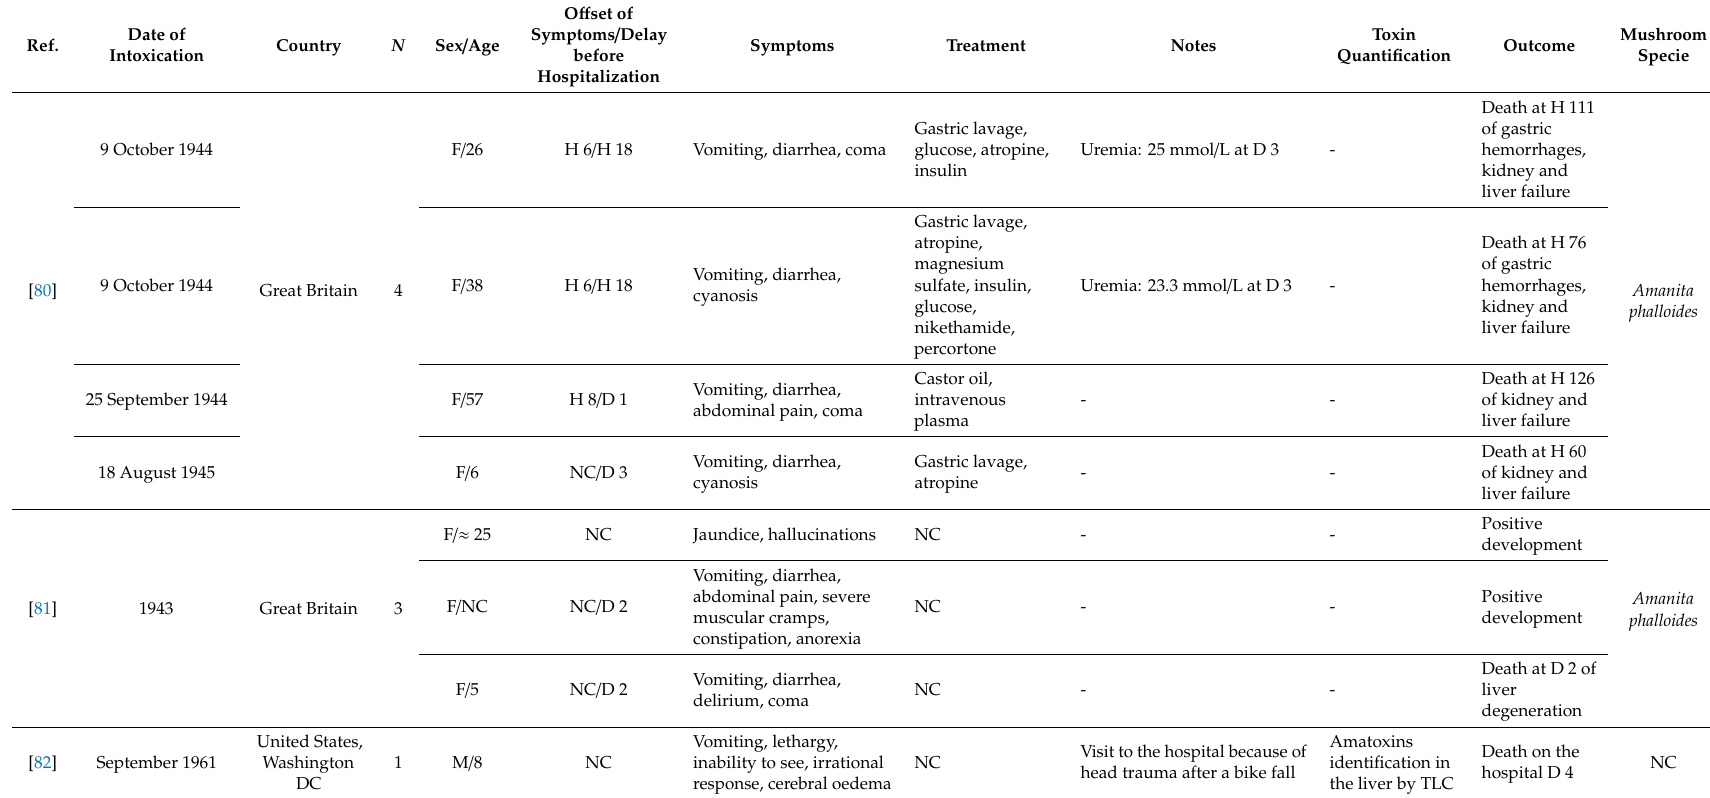
Table 3. Cases of amatoxines